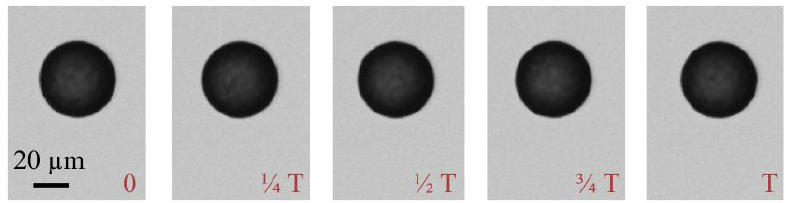
Figure A1. Images of the bead rotation at time 0, ¼ T, ½ T, ¾ T and T for 45 µm beads at 100 Hz driving frequency, where T is the bead rotation period. While the commercial beads look spherical and symmetrical by eye, the software can tell the subtle difference in shape and surface smoothness of the beads, so as to determine the bead rotation